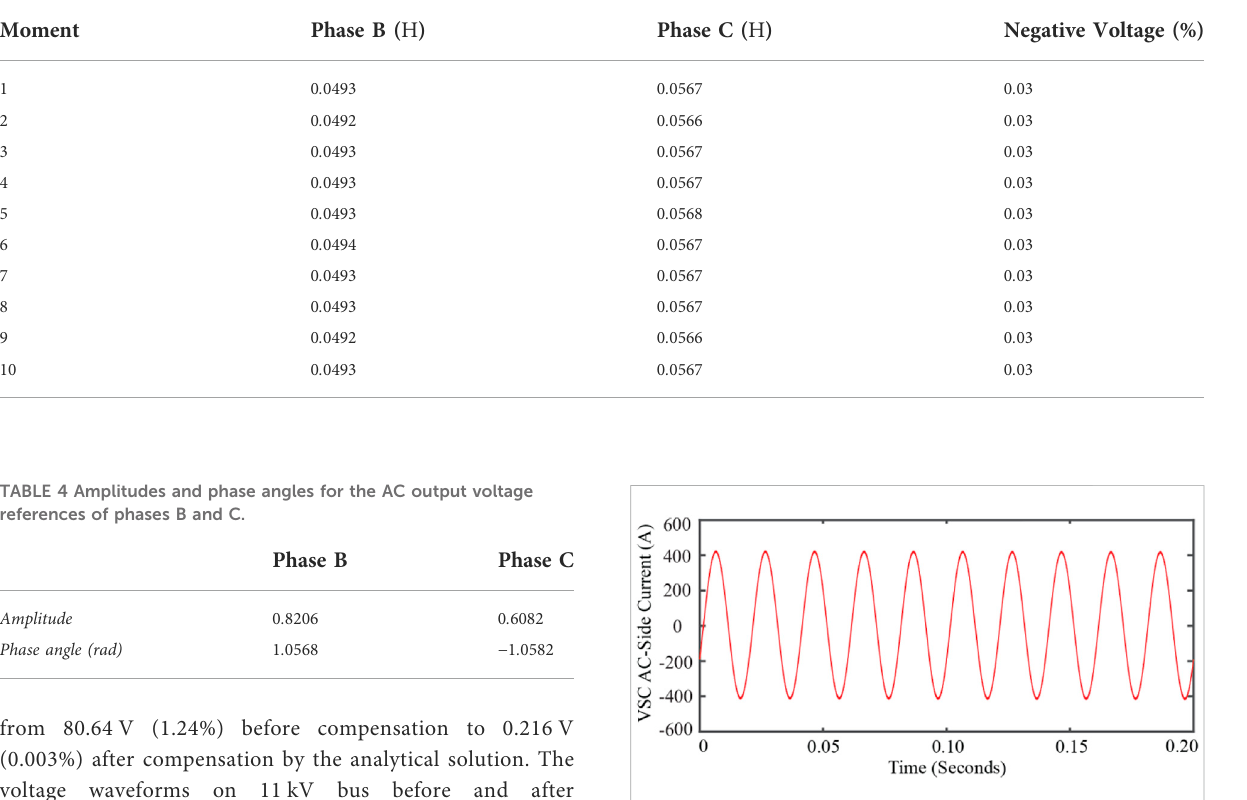
FIGURE 9 AC-side current of the VSC installed on phase